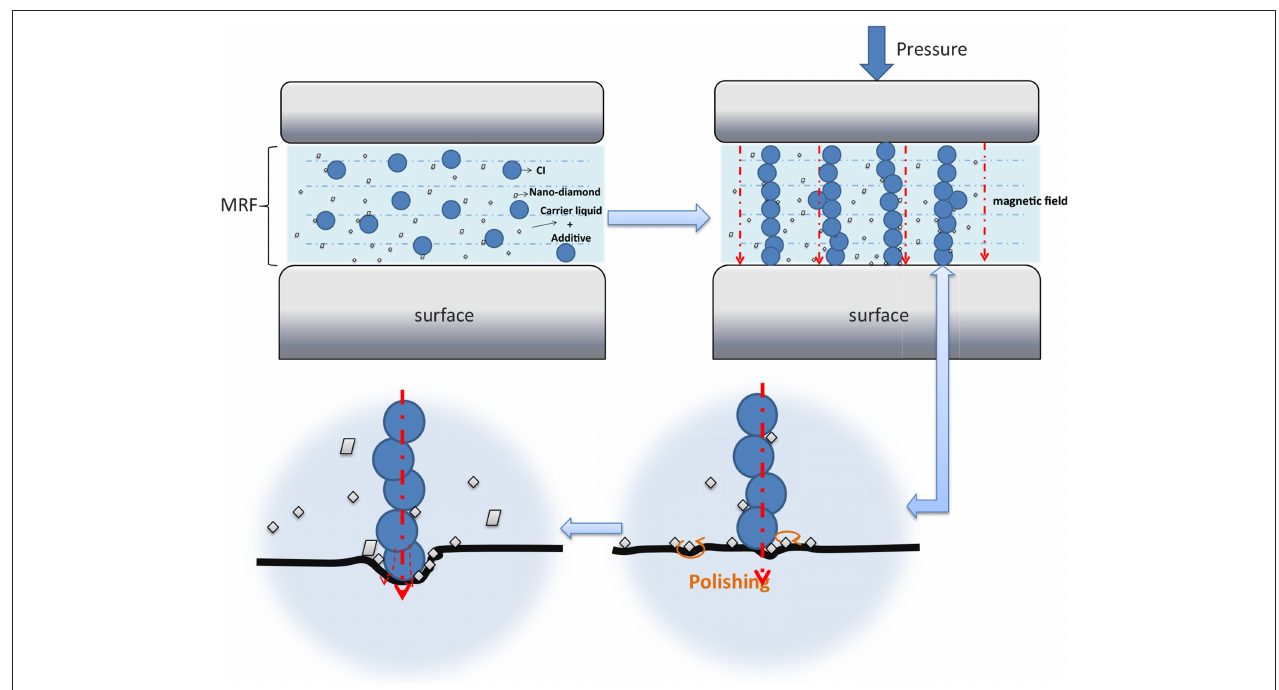
FIGURE 2 | Schematic of the underlying mechanism explaining nanodiamond enhancement of magnetorheologial performance. Polishing mechanisms in the presence of the field enable higher wall friction levels, giving rise to higher shear strengths when the field is applied. Reprinted with permission from Zhao et al.